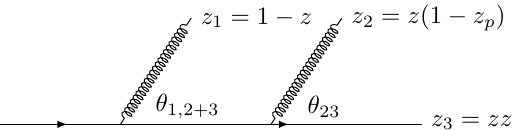
channel. The mapping of F